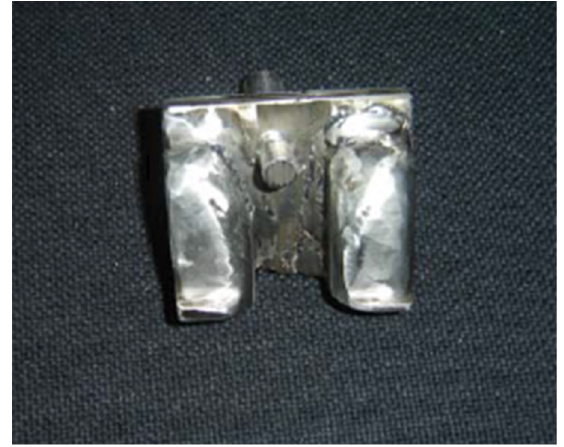
Figure 10. Proximal compression element.